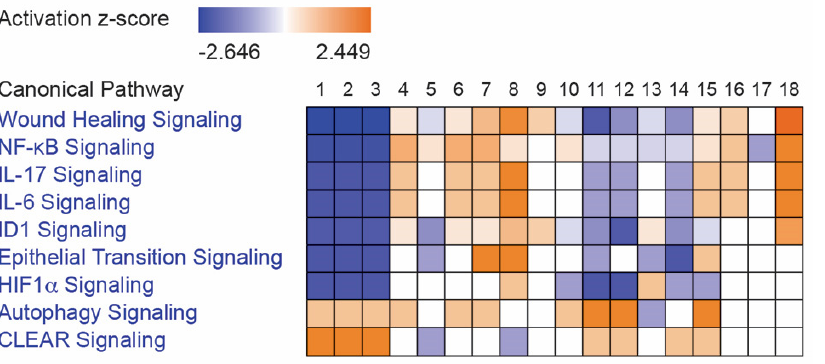
Figure 3. IPA comparison analysis of 18 observations from fibroblasts (observations 1–9) and HEPM cells (observations 10–18) at 0 h (observations 1–3, 10–12), 24 h (observations 4–6, 13–15), and 48 h (observations 7–9, 16–18) after treatment with 255 nm (observations 1, 4, 7, 10, 13, and 16), 405 nm (observations 2, 5, 8, 11, 14, 17), or 255/405 nm (observations 3, 6, 9, 12, 15, and 18) irradiation. Groups are shown as a heatmap, where blue represents inhibition (negative values), white represents midpoint, and orange represents activation (positive values). Numerous IPA canonical pathways were inhibited shortly after irradiation (0 h) but activated at 24 and 48 h. Fibroblasts and HEPM cells both were strongly activated by 405 nm and 255/405 nm UV irradiation treatments.